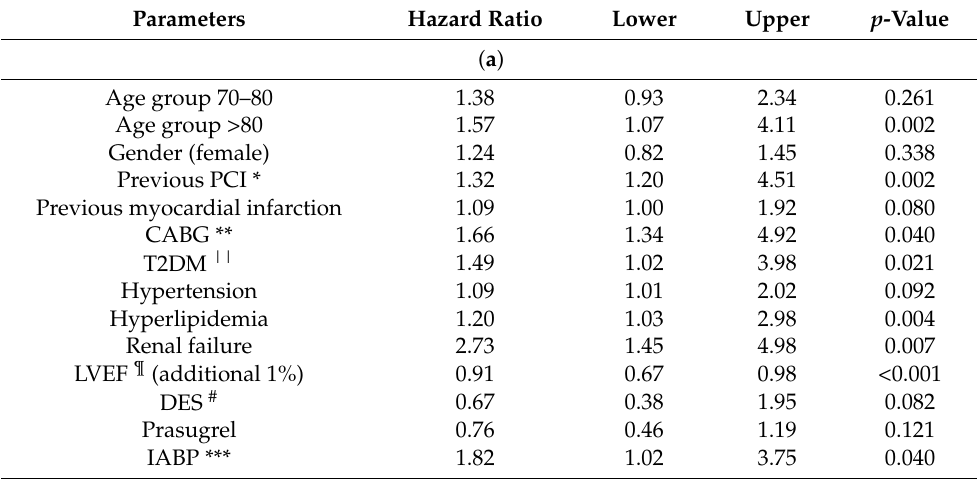
Table 3. ( a ) Univariate analysis of 30-day mortality predictors. ( b ) Cox regression analysis of 3-year mortality